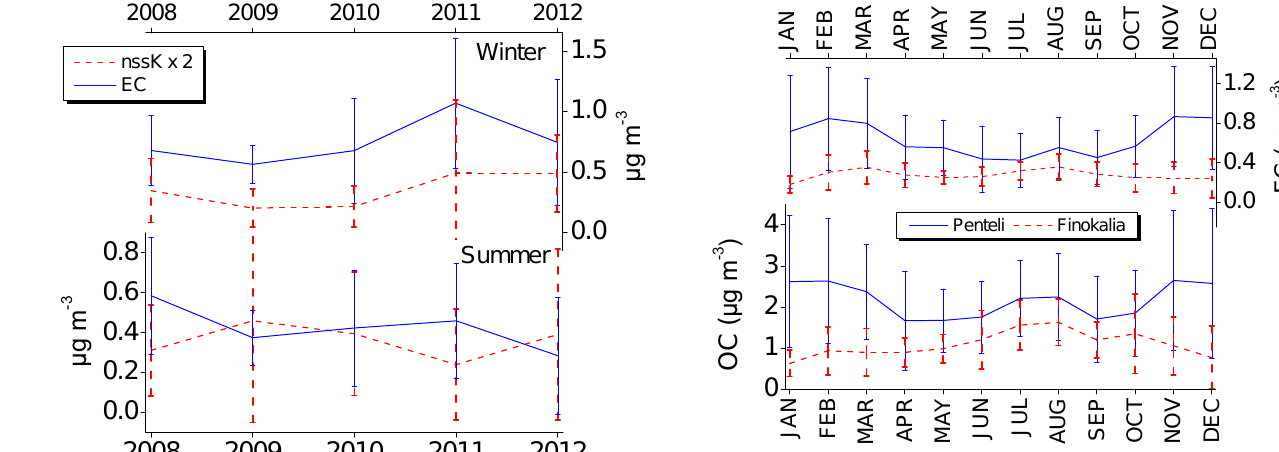
Figure 7. Average summer and winter nss-K + and EC concentra- tions calculated from daily values for the period May 2008–April 2013. Nss-K + concentrations were multiplied by 2 for visualiza- tion purposes.